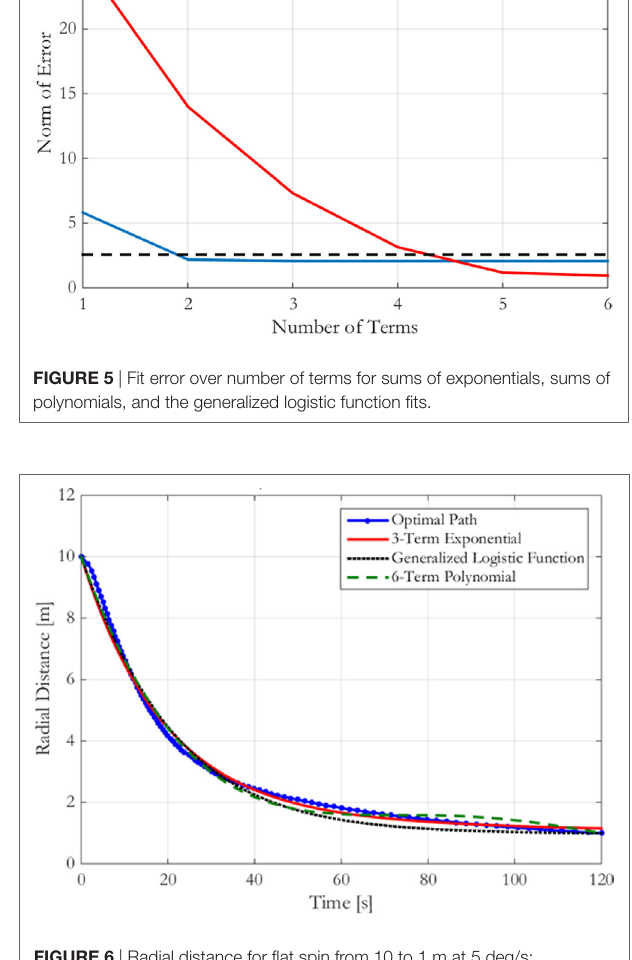
FigUre 6 | Radial distance for flat spin from 10 to 1 m at 5 deg/s: comparing fits with six parameters each.